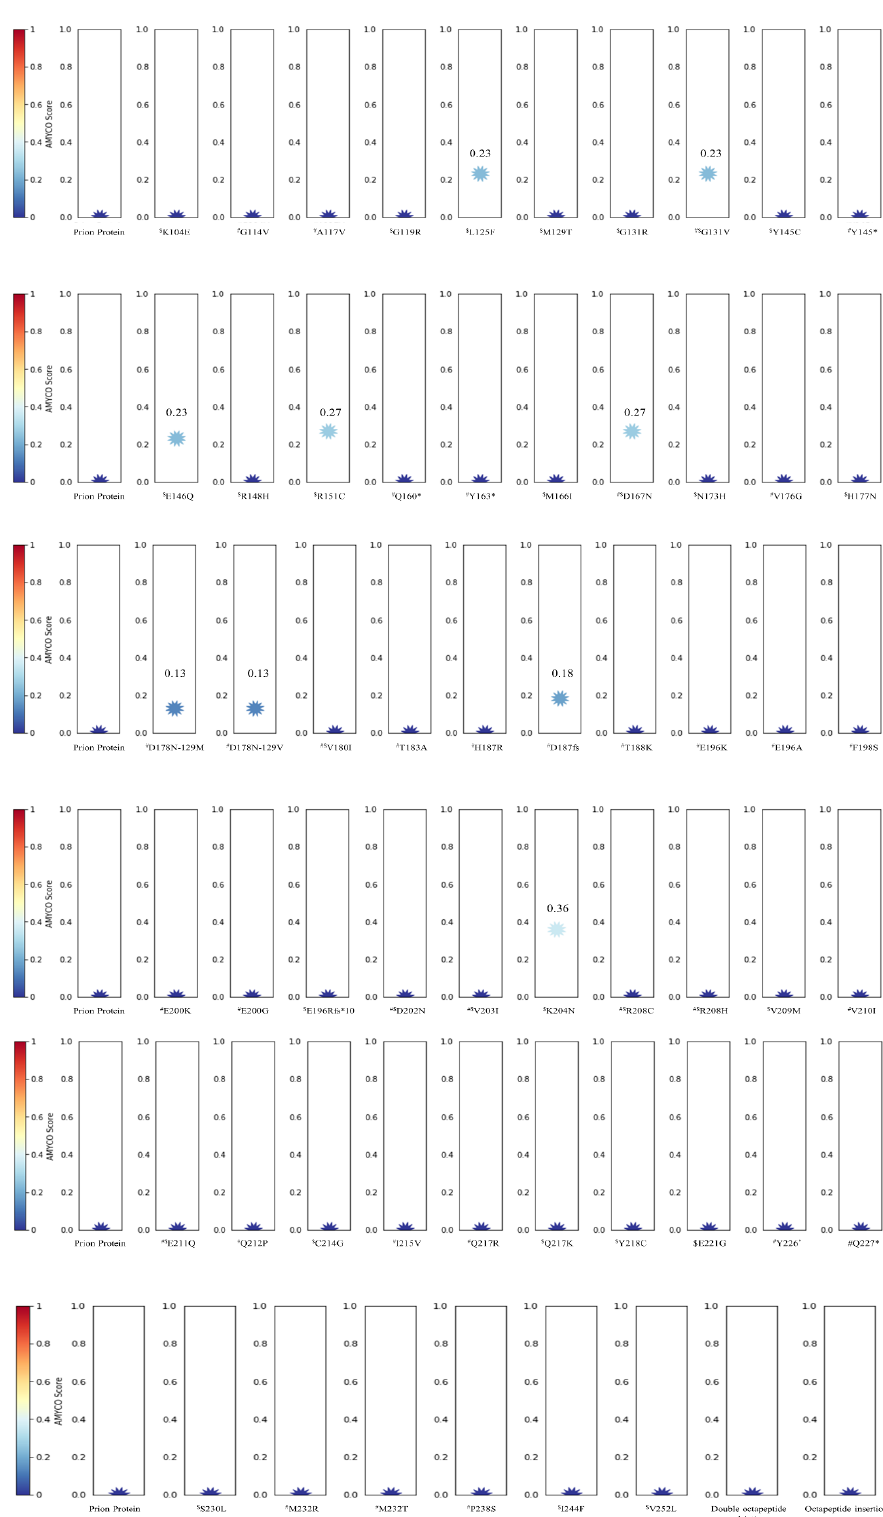
Figure 3. Prediction on amyloid propensity of prion protein (PrP) according to somatic mutations of the prion protein gene ( PRNP ) gene in cancer patients. $ indicates somatic mutations of the PRNP gene in cancer patients. # indicates previously reported pathogenic mutations of the PRNP gene in prion diseases.